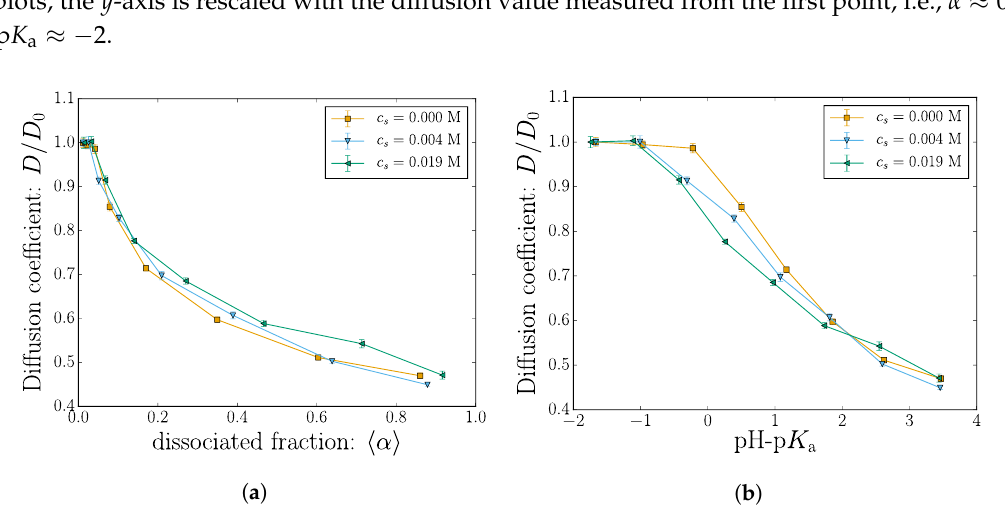
Figure 7. (Color online) The diffusion coefficient D plotted as a function of ( a ) the dissociated fraction and ( b ) pH-p K a . In all cases, the y -axis is rescaled with the value at lowest dissociation α ≈ 0 or pH-p K a ≈ −